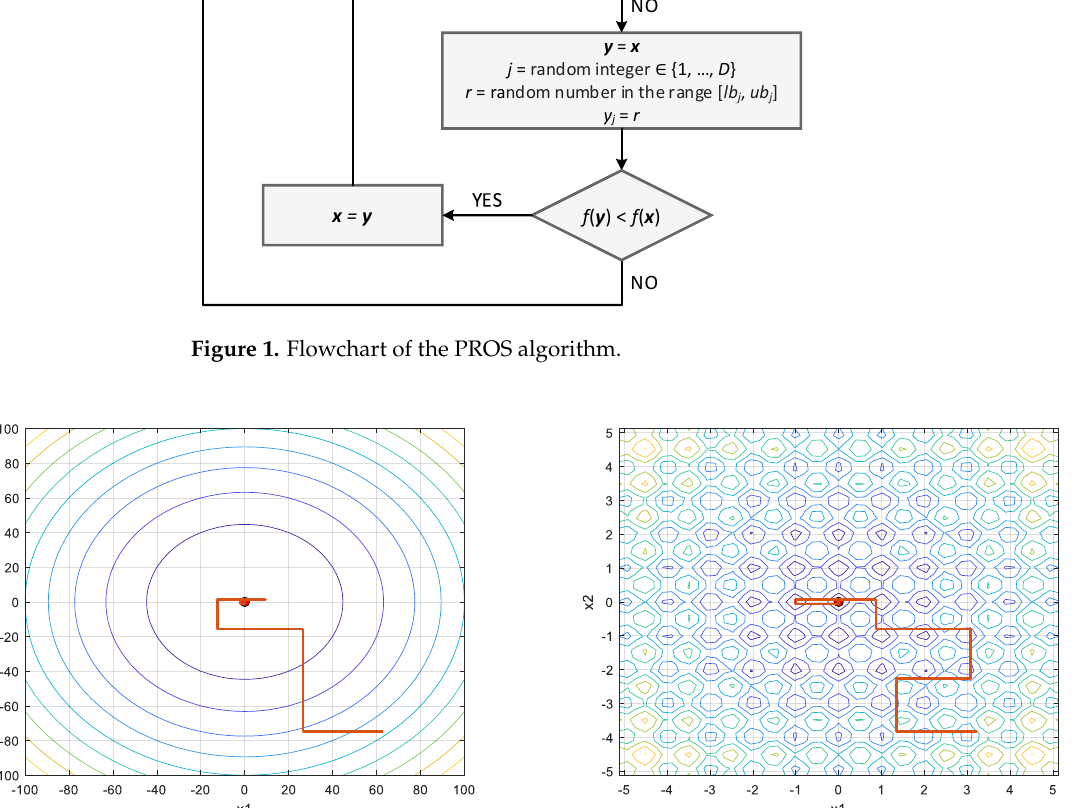
Figure 2. Search path of the PROS algorithm in two 2D problem examples: ( a ) F01-Sphere function (sphere_func) in [ − 100, 100] 2 ; ( b ) F10-Rastrigin’s function (rastrigin_func) in [ − 5.12, 5.12] 2